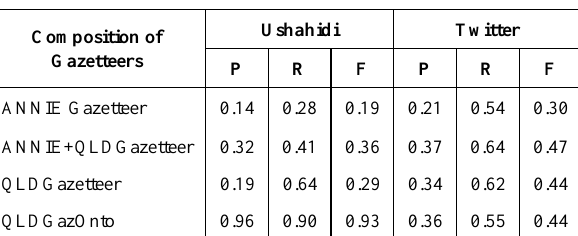
Table 1: Comparison of gazetteer success for Twitter and